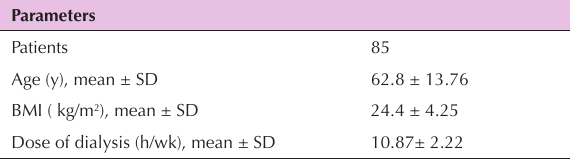
Table 1. Clinical characteristics of the patients Parameters